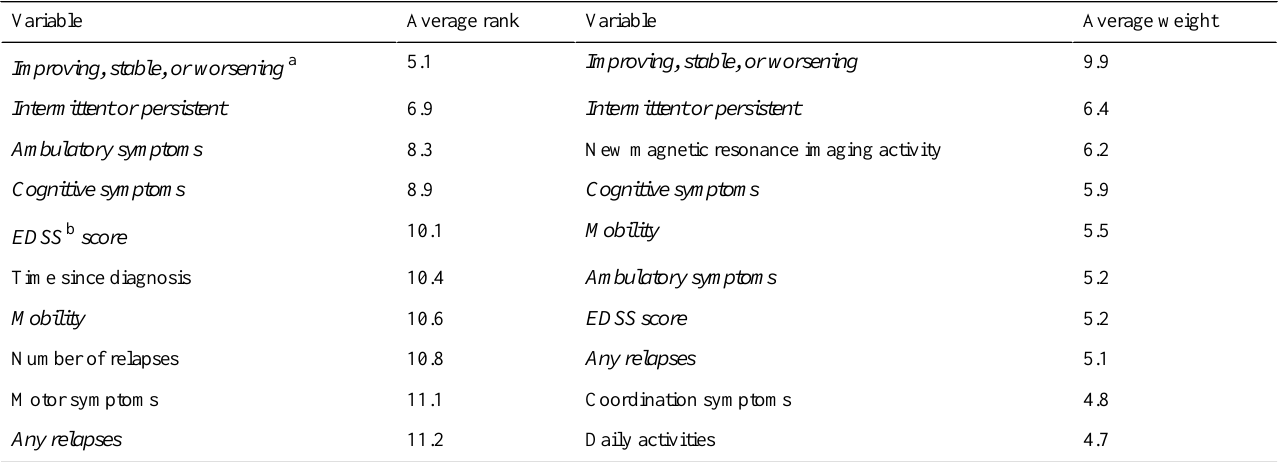
Table 1. Top 10 ranked and weighted